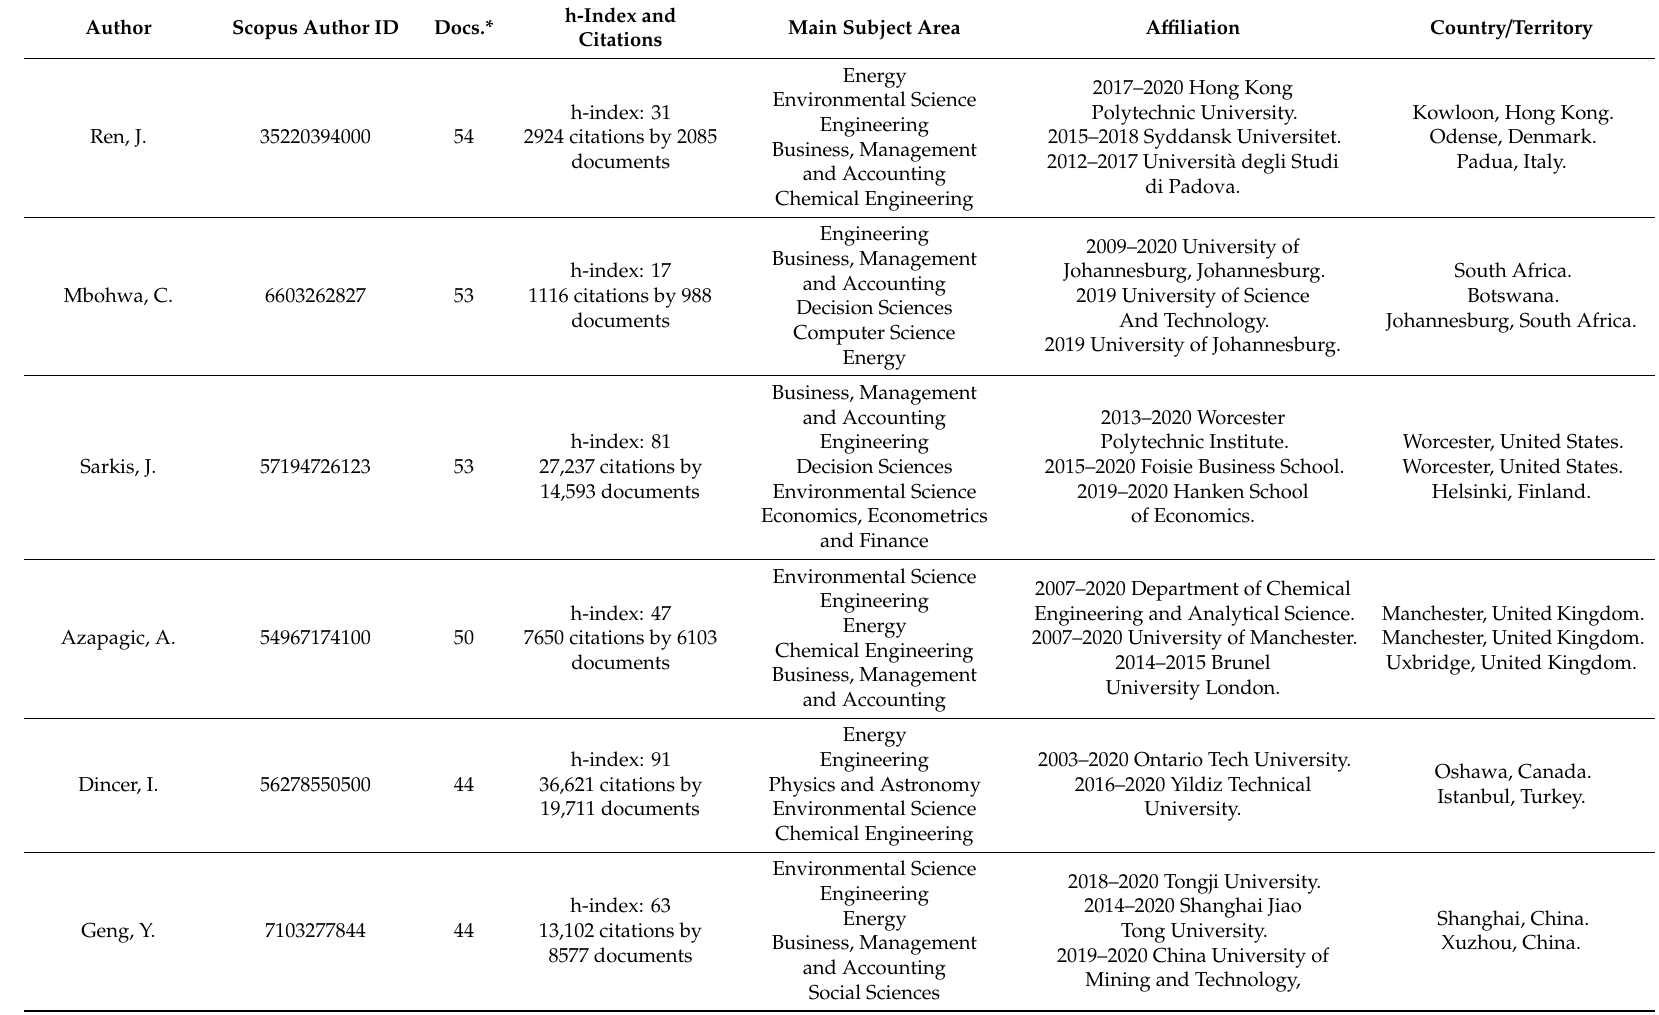
Table 6. Main authors on sustainability in the last 5